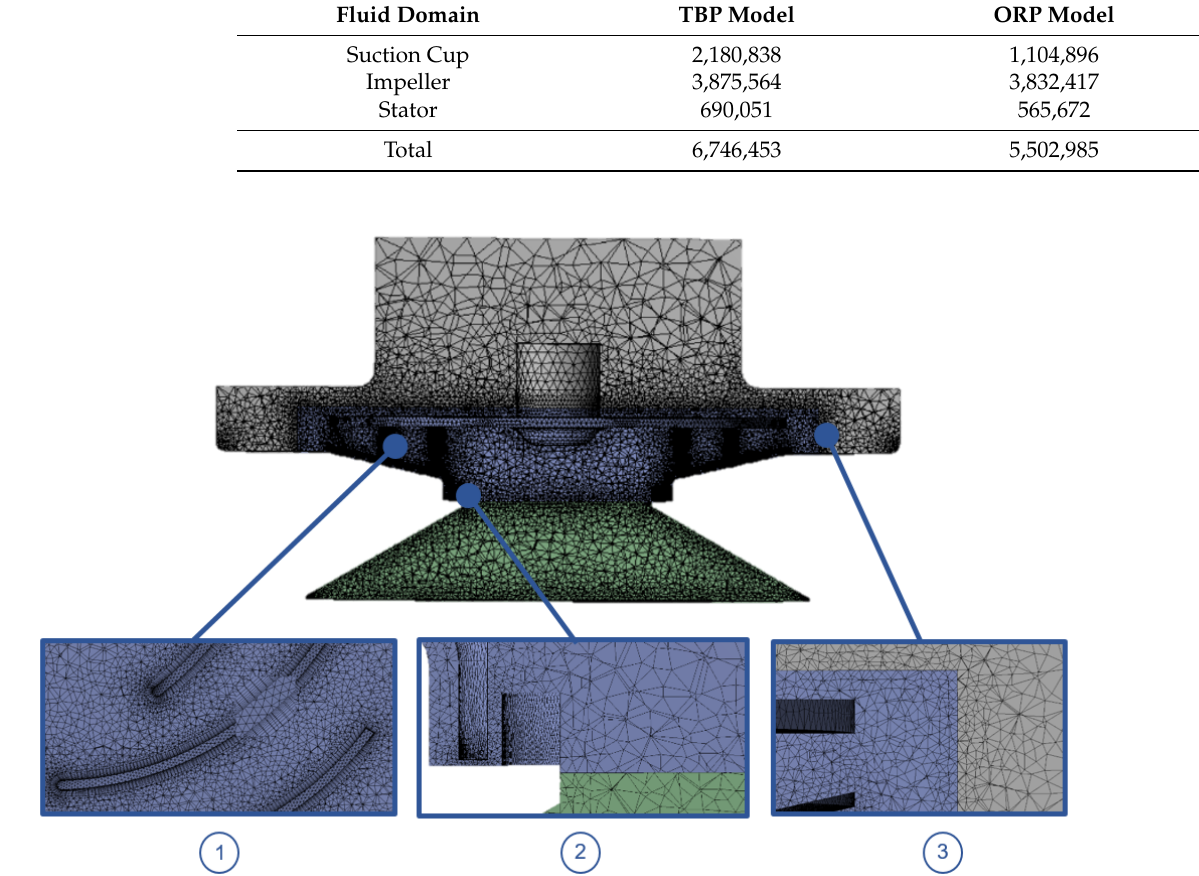
Figure 8. Grid details: ( 1 ) Tetrahedral and prism elements in the impeller blades. ( 2 ) Mesh interface between the suction cup and impeller domains. ( 3 ) Mesh interface between the casing and impeller